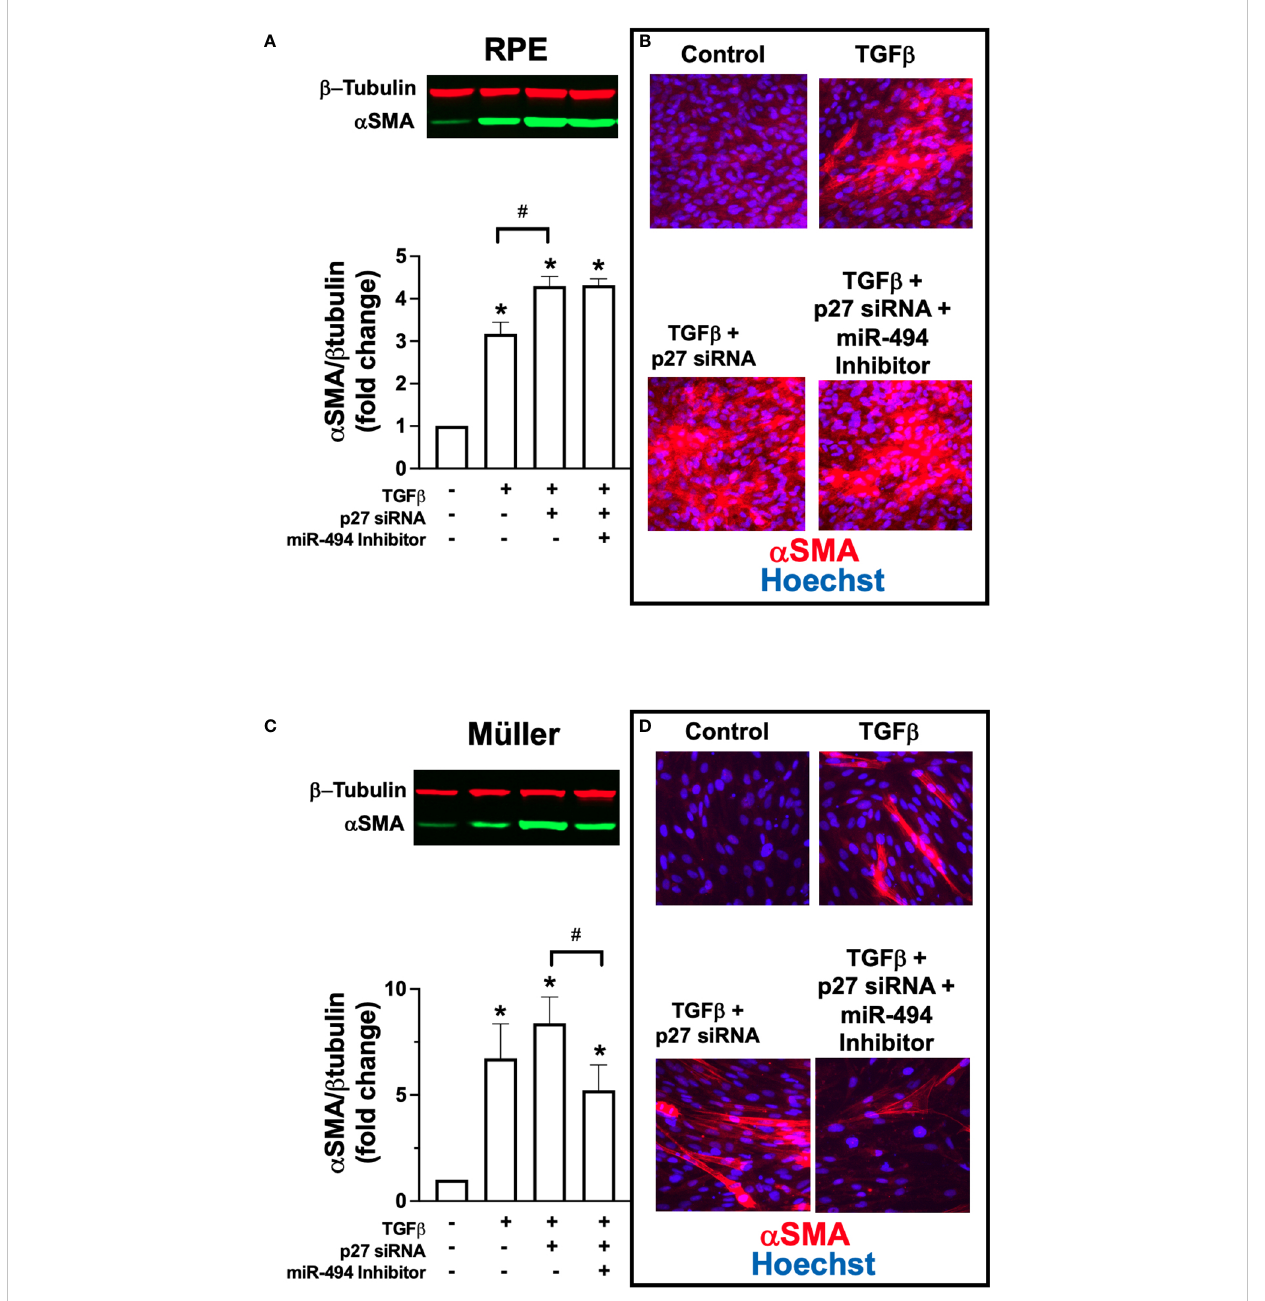
FIGURE 4 Effect of co-treatment with p27 siRNA and miR-494 inhibitor on TGF b -induced a SMA expression. (A) Quanti fi cation of a SMA in RPE cells by immunoblot (representative blots above) after 72h TGF b treatment with and without pre-treatment and co-incubation with miR-494 inhibitor with or without p27 siRNA co-transfection. (B) Representative immuno fl uorescent images of a SMA (red) in RPE cells counterstained with DAPI (blue) after 72h TGF b treatment pre-treatment and co-incubation with miR-494 inhibitor with or without p27 siRNA co-transfection. (C) Quanti fi cation of a SMA in Müller cells by immunoblot (representative blots above) after 72h TGF b treatment with and without pre-treatment and co-incubation with miR- 494 inhibitor with or without p27 siRNA co-transfection. (D) Representative immuno fl uorescent images of a SMA (red) in Müller cells counterstained with DAPI (blue) after 72h TGF b treatment pre-treatment and co-incubation with miR-494 inhibitor with or without p27 siRNA co-transfection. Mean ± SEM, * p<0.05 versus control condition. # p<0.05 between select